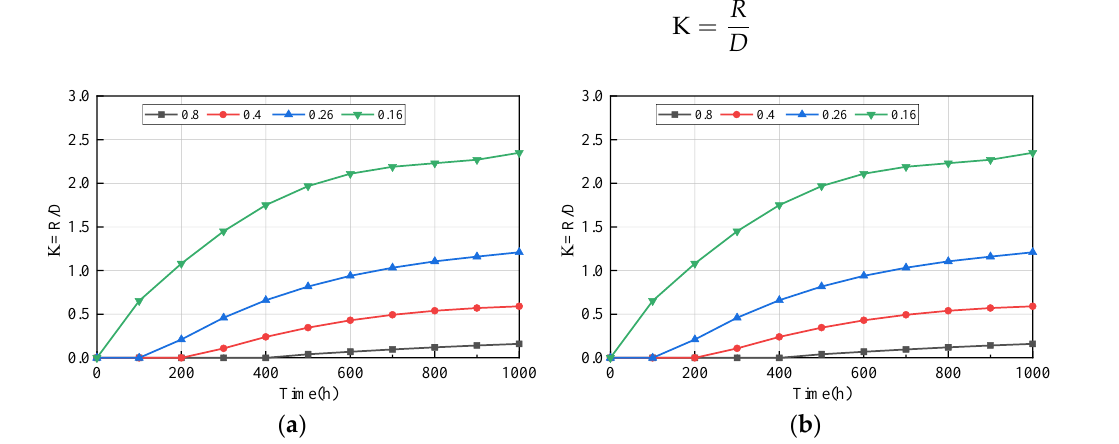
Figure 11. Variation in the extent of plasticity with time under different in situ stresses conditions: ( a ) ξ = 0.3; ( b ) ξ =